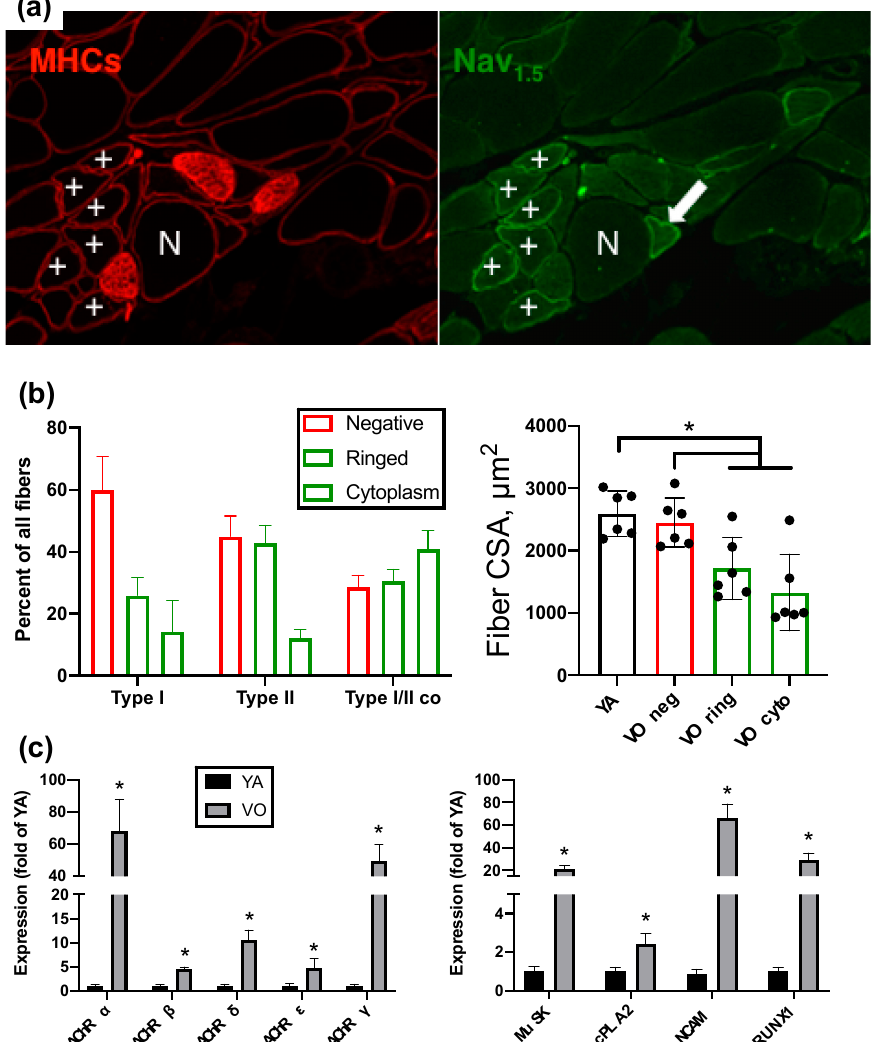
Figure 2. There is a large accumulation of denervated muscle fibers in advanced age, based upon the expression of the denervation-responsive sodium channel isoform, Nav 1.5 , in either the sarcolemmal region (ring; + ) or cytoplasm (arrow). ( a ) Left panel shows muscle fibers from 35 mo old rat gastrocnemius muscle labeled with primary antibody against MHCs = slow (type I) myosin heavy chain and laminin (both on same fluorescent secondary antibody). Right panel shows a serial section where muscle fibers are labeled with primary antibody against Nav 1.5 . N = Nav 1.5 negative fiber; “+” symbols identify Nav 1.5 positive fibers. ( b ) Nav 1.5 status by fiber type, and size of fibers by Nav 1.5 status. Filled circles in right hand panel represent the individual values for each animal. ( c ) The expression of AChR subunits are elevated in very old muscle, particularly the reinnervation-denervation responsive α and γ subunits, coincident with a marked upregulation of other denervation-responsive genes ( MuSK, cPLA2, NCAM, RUNX1 ). YA = young adult; VO = very old (35 mo old). * p < 0.05 versus VO Nav 1.5 ring and Nav 1.5 cyto. Data are taken from [7,24].